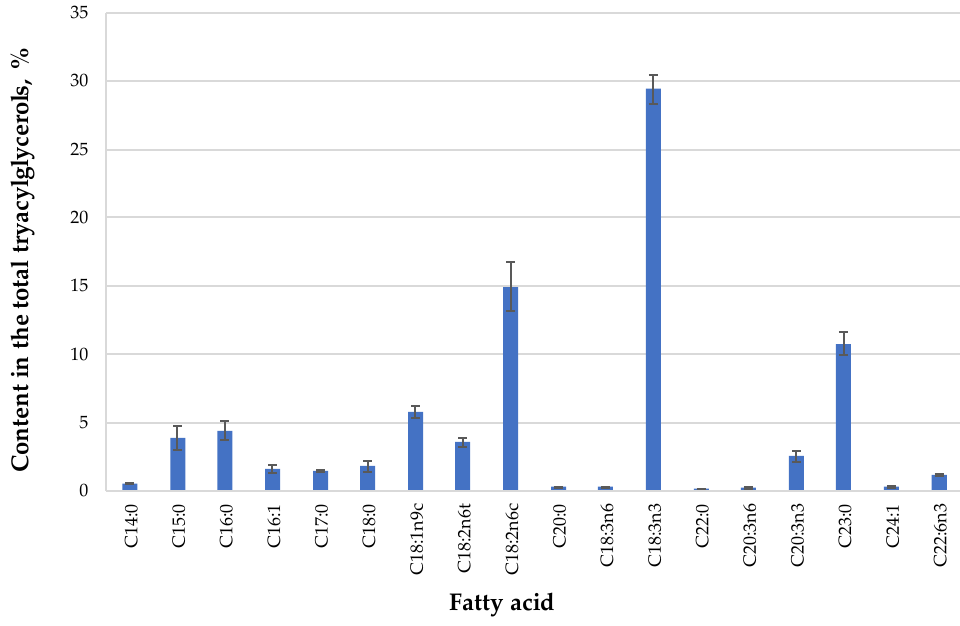
Figure 1. The fatty acid composition of Dasiphora fruticosa leaves oil extract extracted by supercritical carbon dioxide (SFE-CO 2 ) (45 MPa, 60 °C, 360 min), expressed as percentage ± standard deviation of the total GC-FID peak area of fatty acid methyl esters (FAME) ( n = 3).